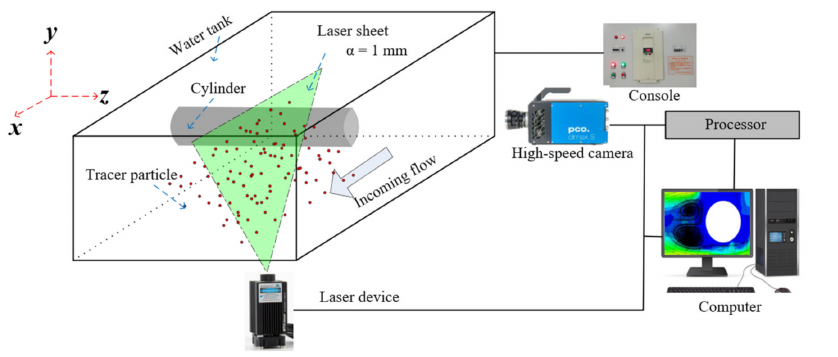
Figure 1. The experimental set-up for the PIV experiments in the circulating tank (only a partial side view of the tank is